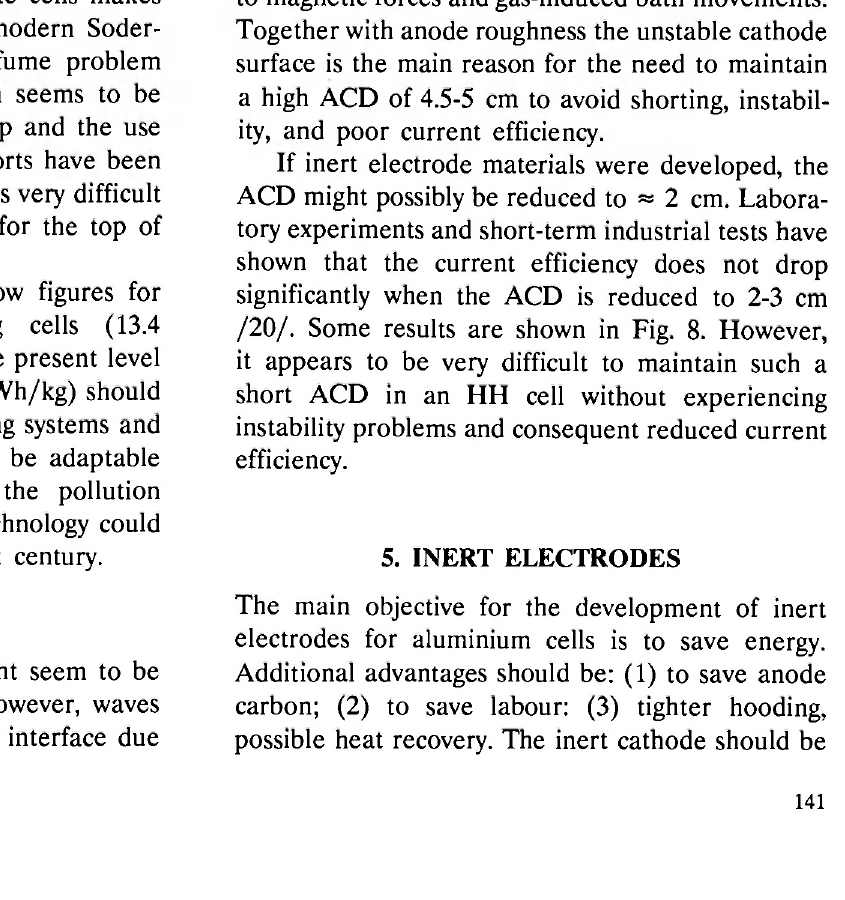
Fig. 6: Sketch of cross section of aluminium cell with prebaked anodes and automatic crustbreaking and alumina